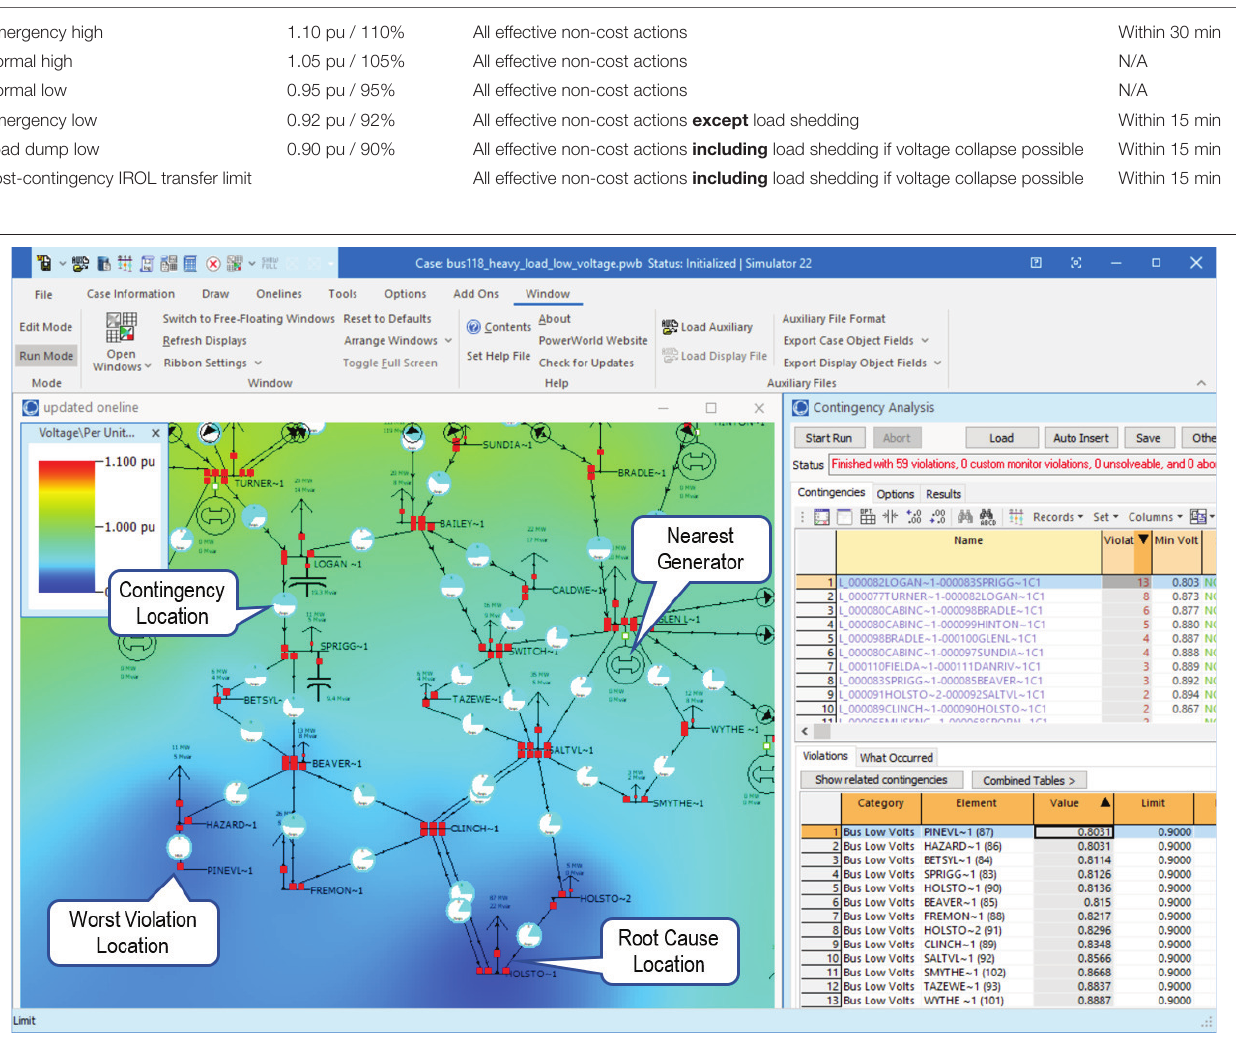
FIGURE 2 | An annotated view of PowerWorld, demonstrating the observations made by an operator seeking to resolve the undervoltage violation described in Section